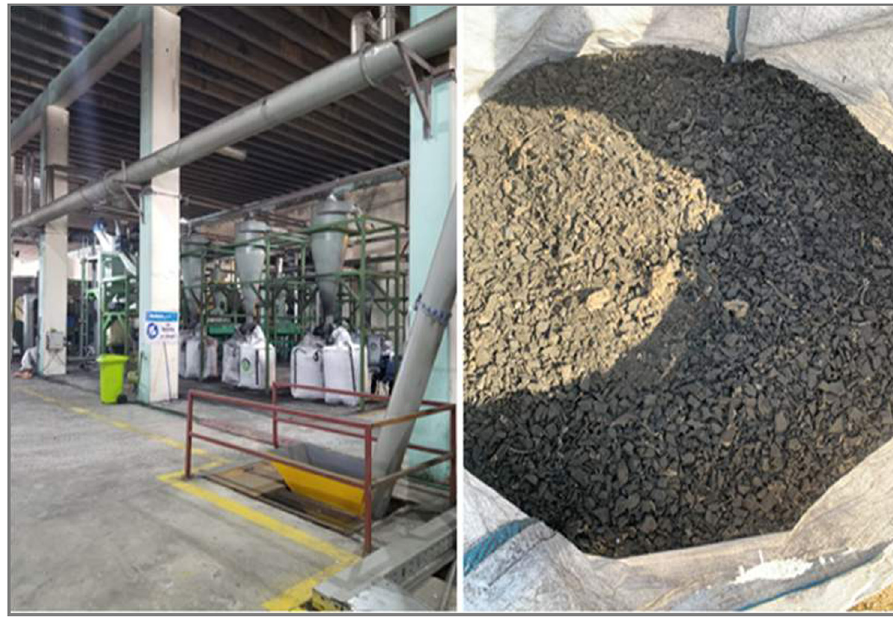
Figure 11: Production of rubber material in the factory.